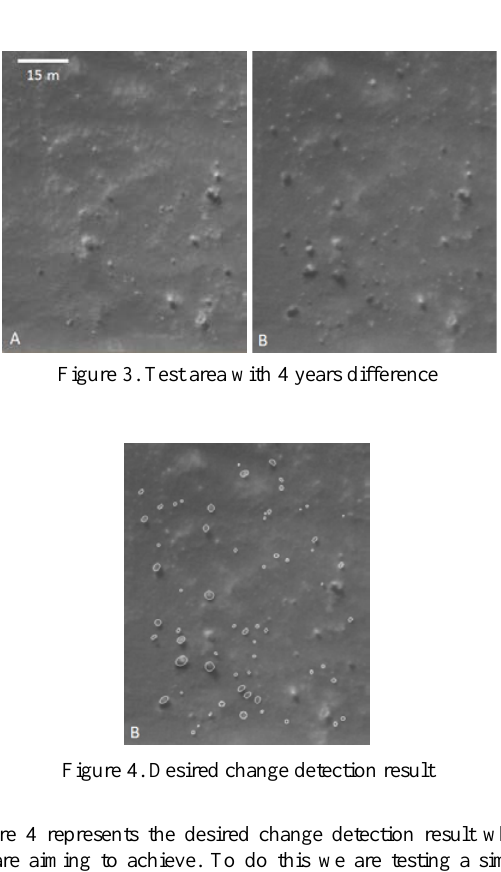
Figure 2. North polar steep scarp with 4 years difference